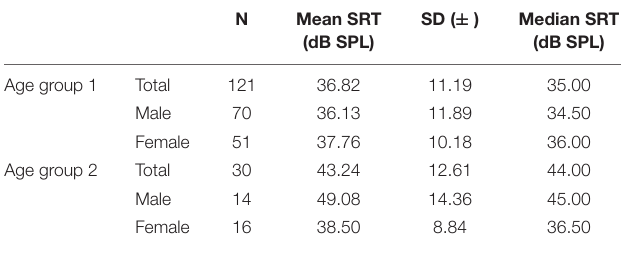
TABLE 5 | Speech reception threshold (dB SPL) according to main variables age and sex.